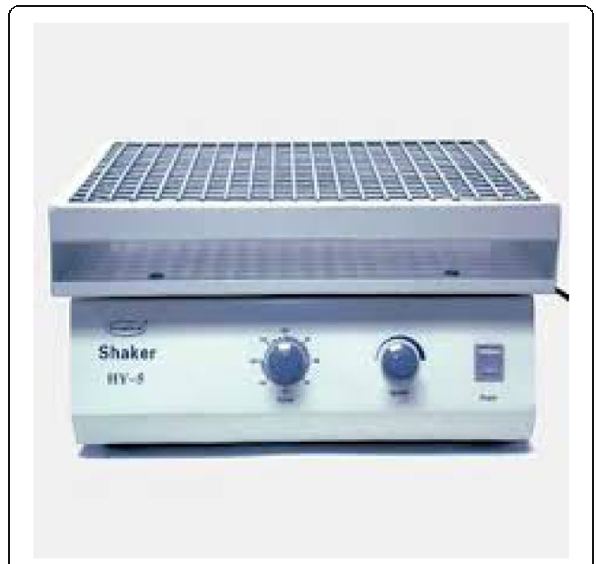
(cid:1) Drying process may be accelerated by heating the article in an oven at 50 °C. Red colored fingermarks develop on pink background (Beaudoin 2004, 2011; Salma et al.